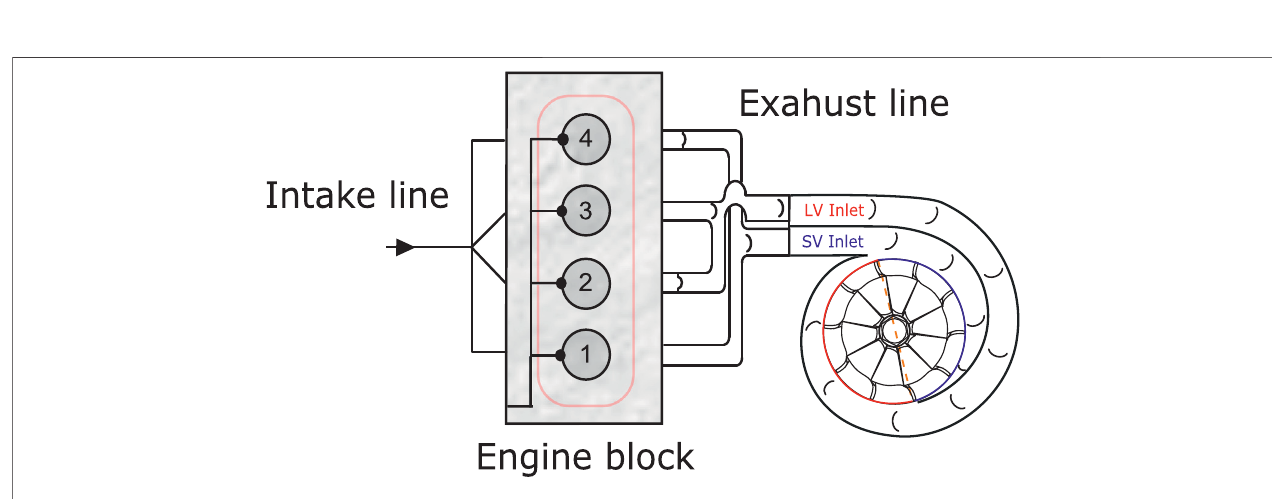
FIGURE 3 | Pressure and temperature sensor instrumentation on the exhaust line of the engine.